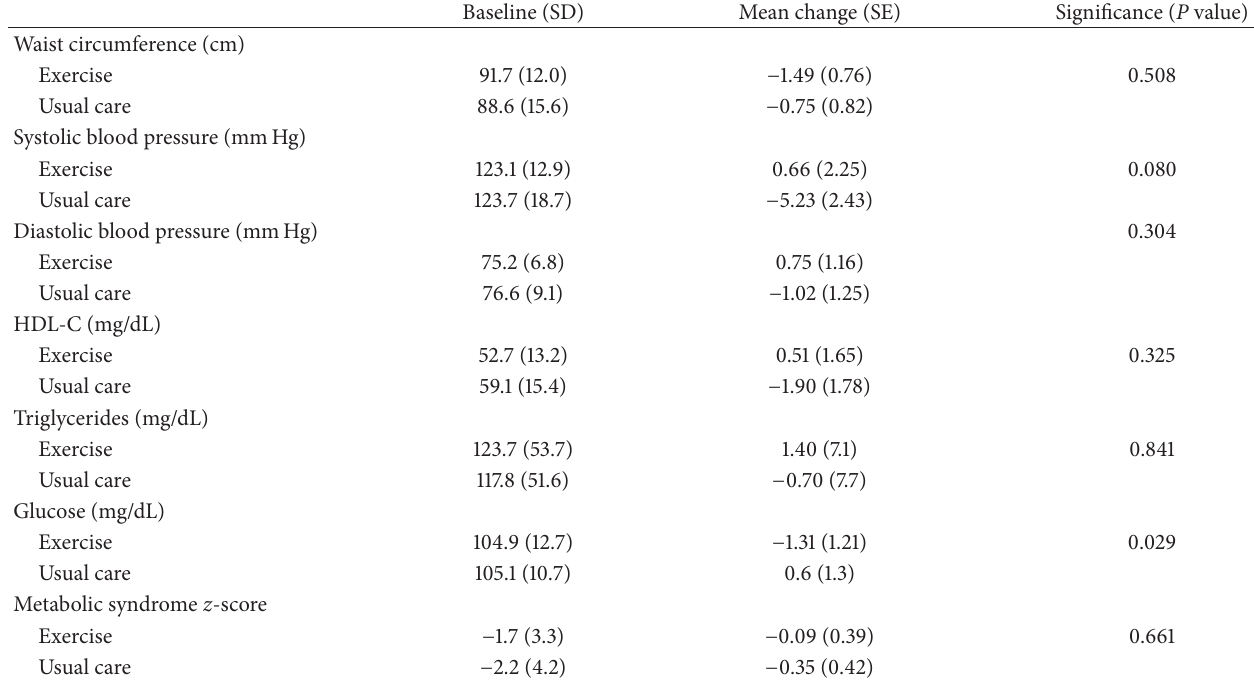
Table 3: Six-month change in metabolic syndrome variables in exercise intervention ( 𝑛 = 35 ) versus usual care ( 𝑛 = 30 ).